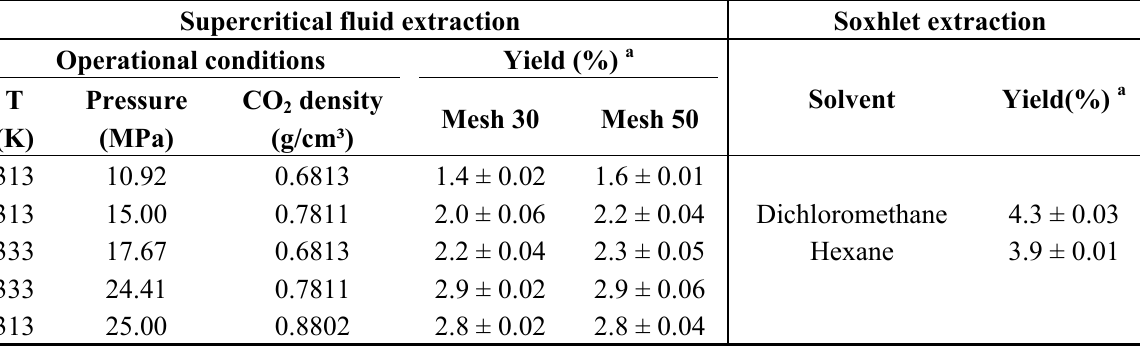
Table 1. Overall yields of C. brasiliense extracts obtained by SFE and Soxhlet